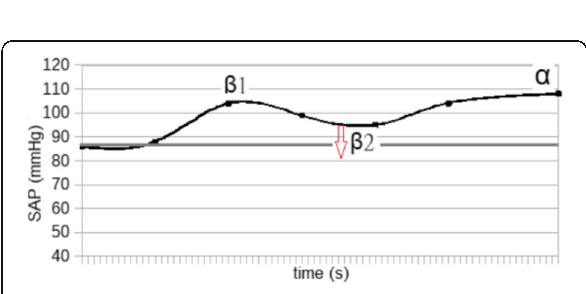
Fig. 7 (abstract A16). Septic